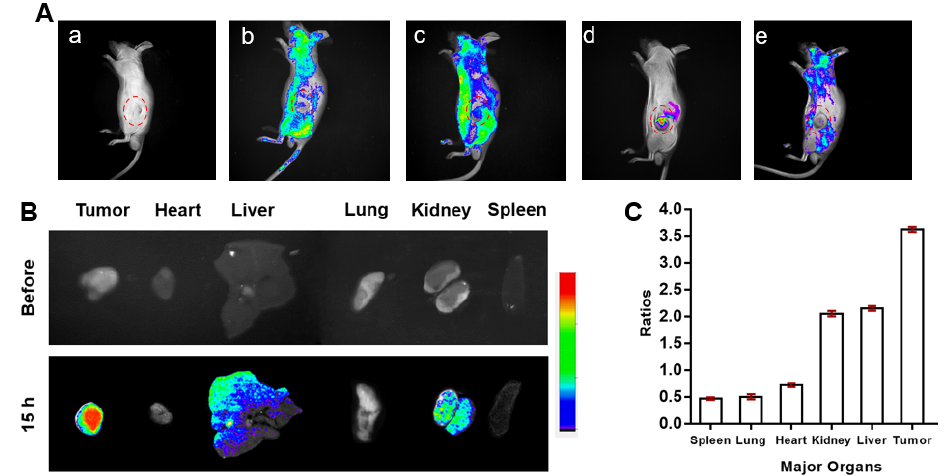
Figure 6. In vivo and ex vivo fluorescence imaging. ( A ) In vivo fluorescence imaging of P2 (0.5 mg/kg) in DU-145 tumor-bearing mice at different time points (0, 3, 6, 15, and 36 h). ( B ) Ex vivo fluorescence imaging of the tumor and major organs at 15 h after the injection of the probe. ( C ) Regions of interest (ROI) analysis of signal-to-background